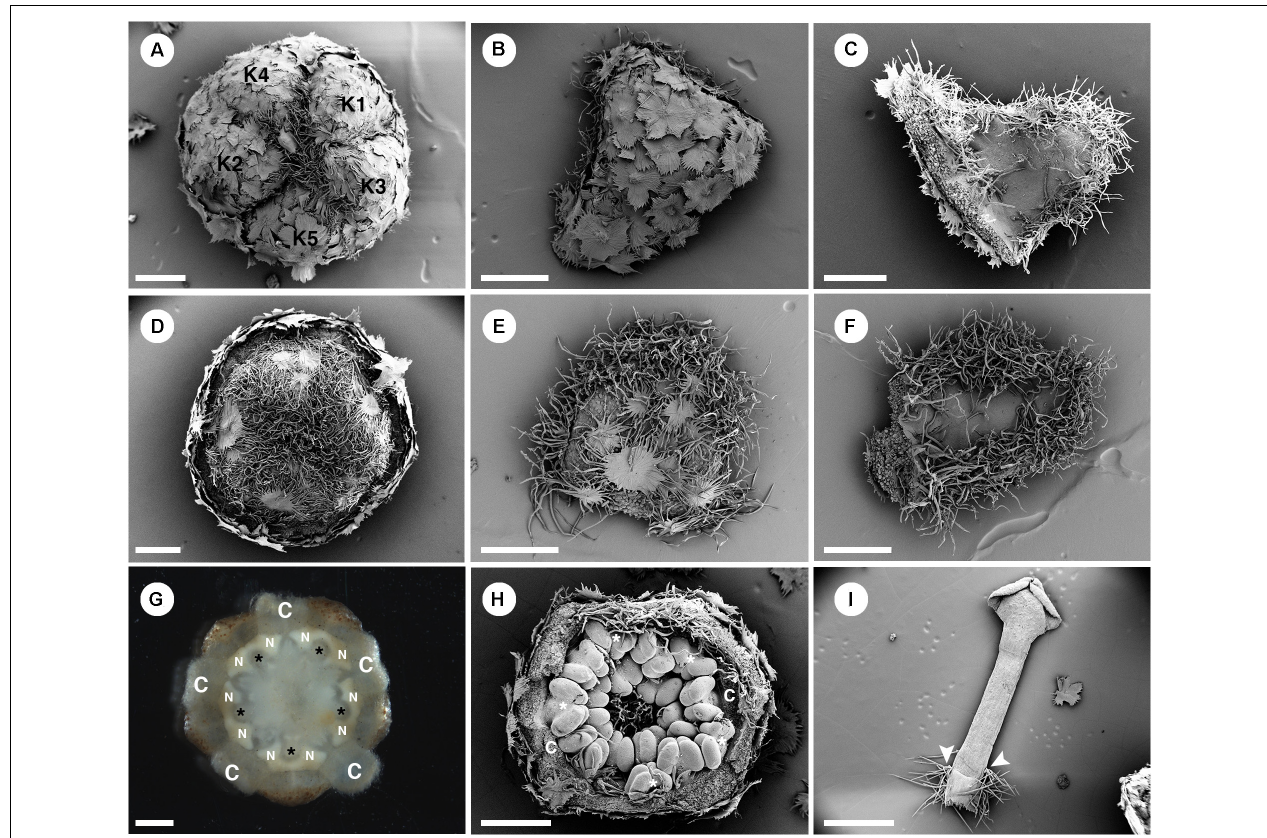
FIGURE 7 | Morphology of staminate flowers from Croton alabamensis . (A) Calyx in the flower bud with quincuncial aestivation. Note, interlocking of trichomes on the floral apex. (B) Abaxial surface of a sepal covered with lepidote trichomes. (C) Adaxial surface of a sepal covered with some stellate trichomes on the lower part. There are many stellate trichomes on the margin. (D) Corolla in a flower bud with quincuncial aestivation. (E) Abaxial surface of a petal covered with stellate-lepidote trichomes. There are many trichomes on the margin. (F) Adaxial surface of a petal. The central area is glabrous but there are tufts of simple trichomes on the margin. (G) Horse-shoe shaped nectary glands clasping the base of outer antesepalous stamens (asterisk). (H) Stamens in the cup-shaped floral bud. The outermost stamens are arranged alternating with petals (asterisk). Note, stamens are not inflexed in bud. (H) A stamen with some stellate trichomes on the filament base (arrowhead). K, sepal; C, petal; N, nectary. Scale bars: (A–F,H) = 500 µ m; (G,I) = 1,000 µ